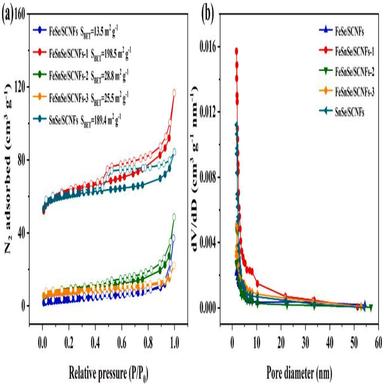
(a) Brunauer–Emmett–Teller curves and (b) the associated pore size distribution curves of FeSe/SCNFs, FeSnSe/SCNFs-1, FeSnSe/SCNFs-2, FeSnSe/SCNFs-3 and SnSe/SCNFs.